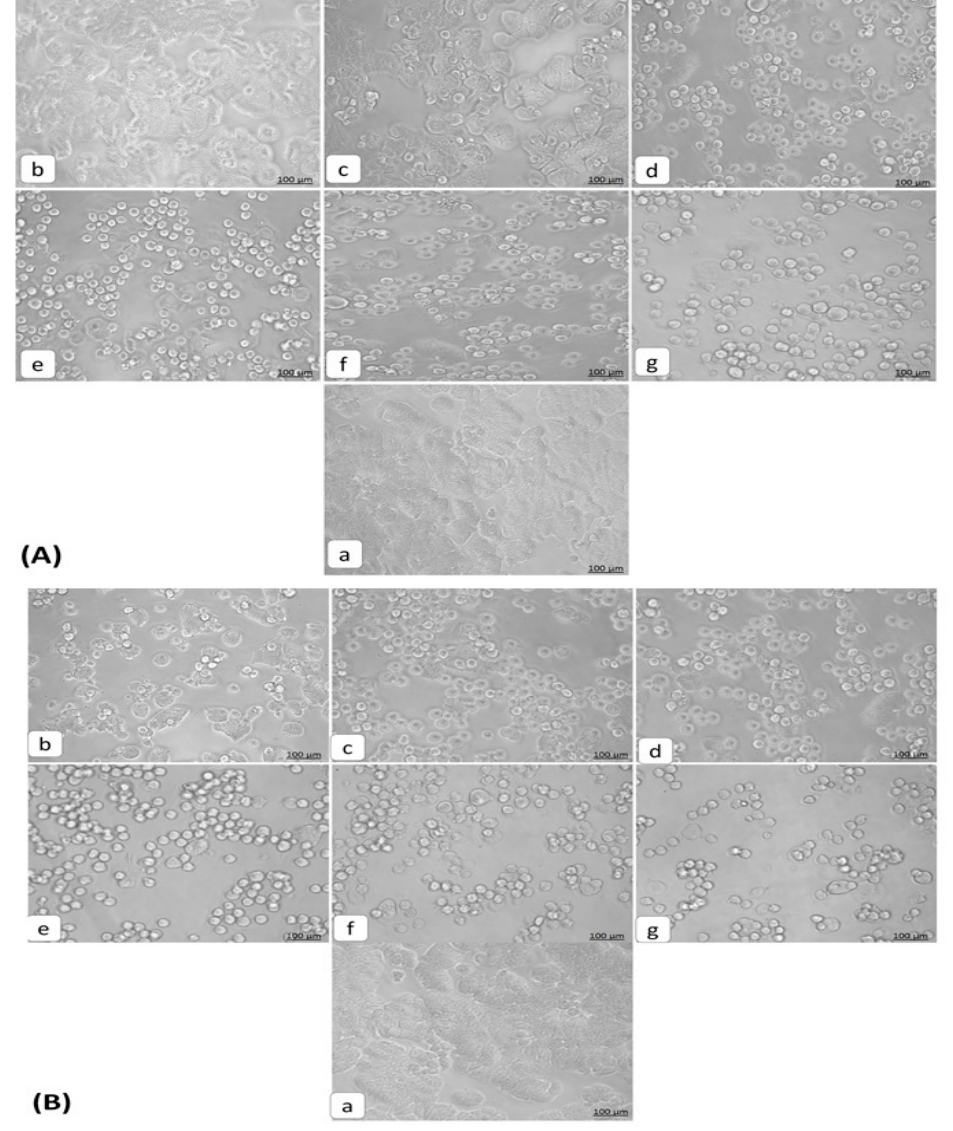
Figure 3. Morphological changes observed in HT29 cells on exposure to orientin and irinotecan. HT29 cells treated with different concentrations of orientin ( A ) and irinotecan ( B ) were observed after 24 h by inverted bright field microscopy (100 µm). ( a ) Untreated control, ( b ) 3.125 µM, ( c ) 6.25 µM, ( d ) 12.5 µM, ( e ) 25 µM, ( f ) 50 µM and ( g ) 100 µM. The treated cells were found to be shrunken, rounded off and detached from the layer.